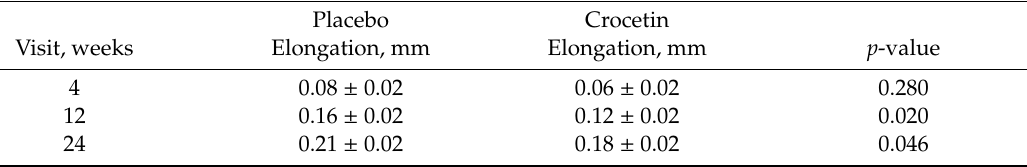
Table 3. The adjusted means of cycloplegic SER change and AL change in both eyes at each visit. a The Adjusted Mean of Cycloplegic SER Change in both Eyes at Each Visit Placebo